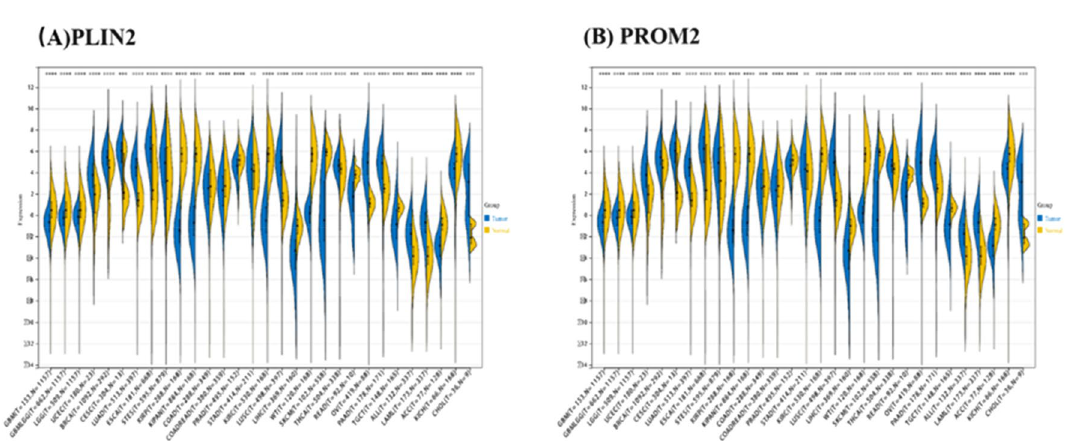
Figure 10. Validation of hub genes in various tumors. ( A , B ) Differences in expression of the PLIN2 ( A ) and PROM2 ( B ) genes in various tumors. * P <